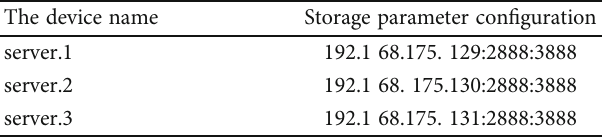
Table 7: Con fi guration of Zookeeper storage